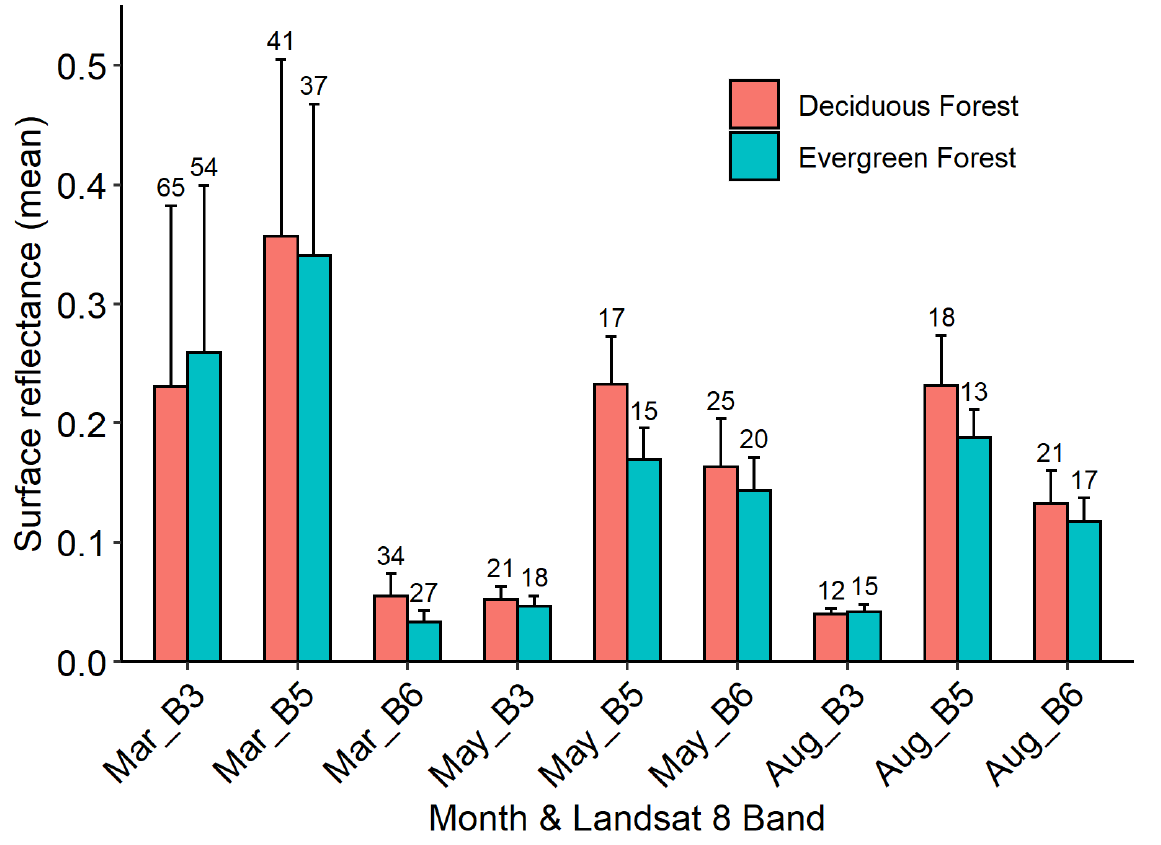
Figure 5. Mean and standard deviation (1 σ ) of surface reflectance in visible (B3), near-infrared (B5), and shortwave infrared (B6) bands of Landsat 8 in March, May, and August 2014 for deciduous forest and evergreen forest. The coefficient of variation (%) is labeled in each bar.